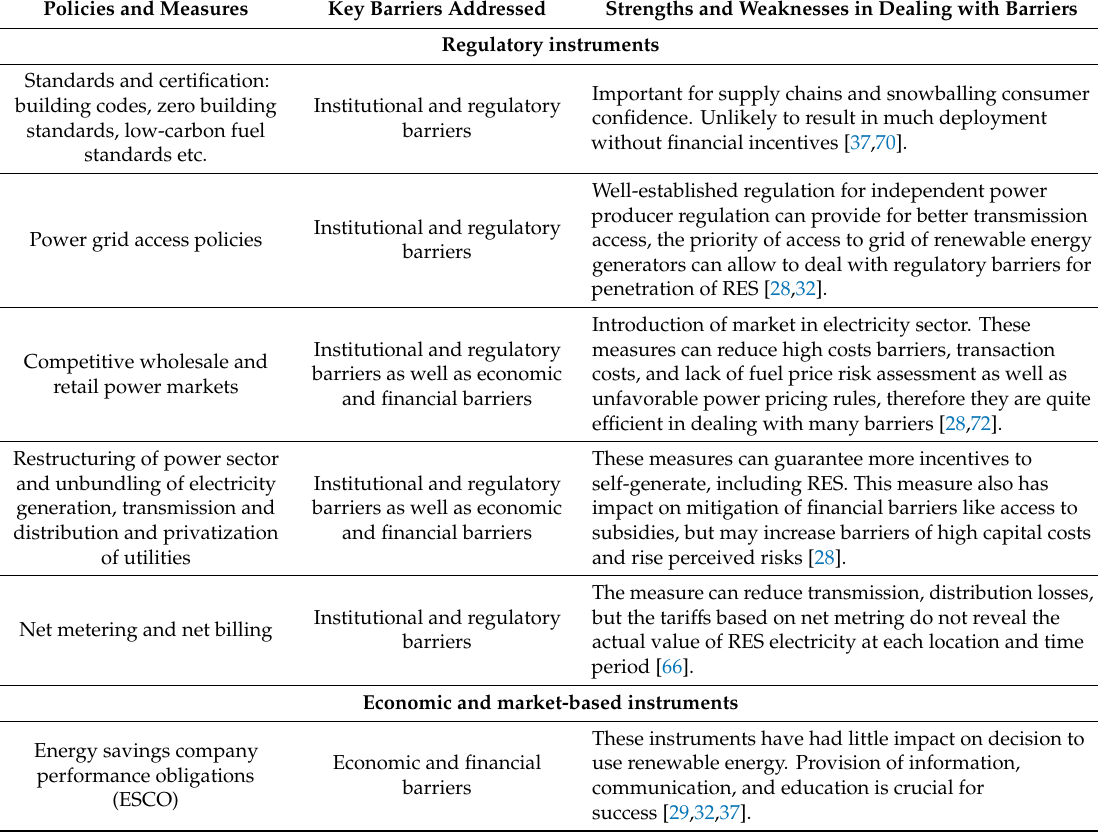
Table 4. The e ff ectiveness of policies and measures to address barriers of